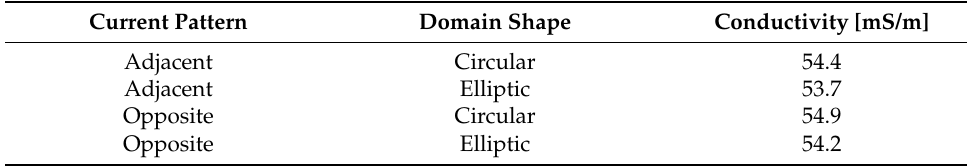
Figure 7. The pattern defining the ( a ) minimization function, and ( b ) the conductivity value during the optimization. Table 1. The results: the optimization of the initial